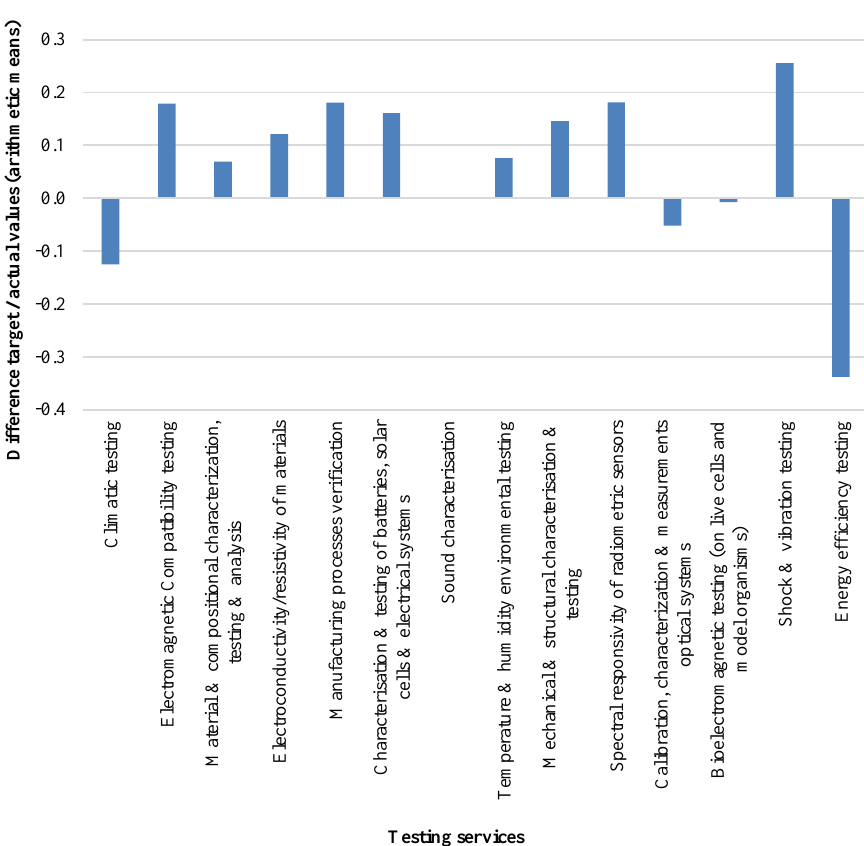
Fig. 3. Difference target/actual values (arithmetic means) –